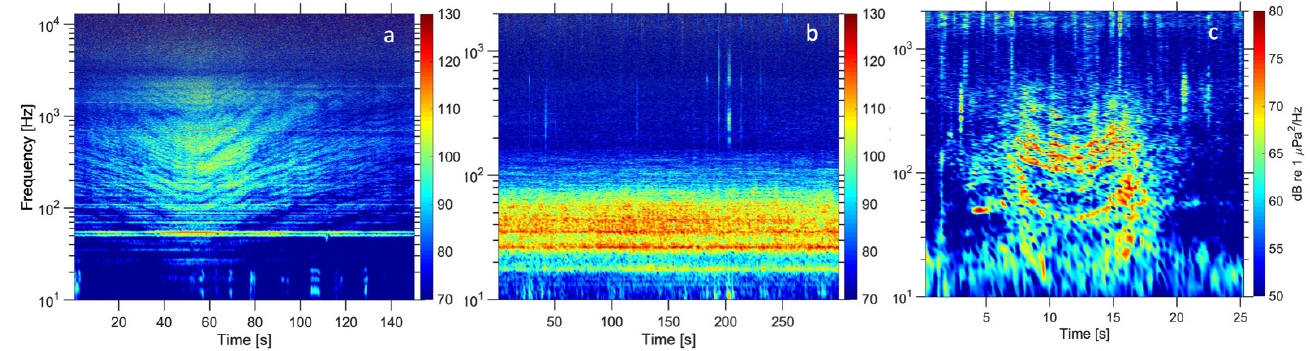
Figure 6. Sources of anthropophony from left to right: small vessel ( a ), large vessel ( b ), and airplane flying overhead ( c ). Note that the frequency axes and colour bars have different ranges.